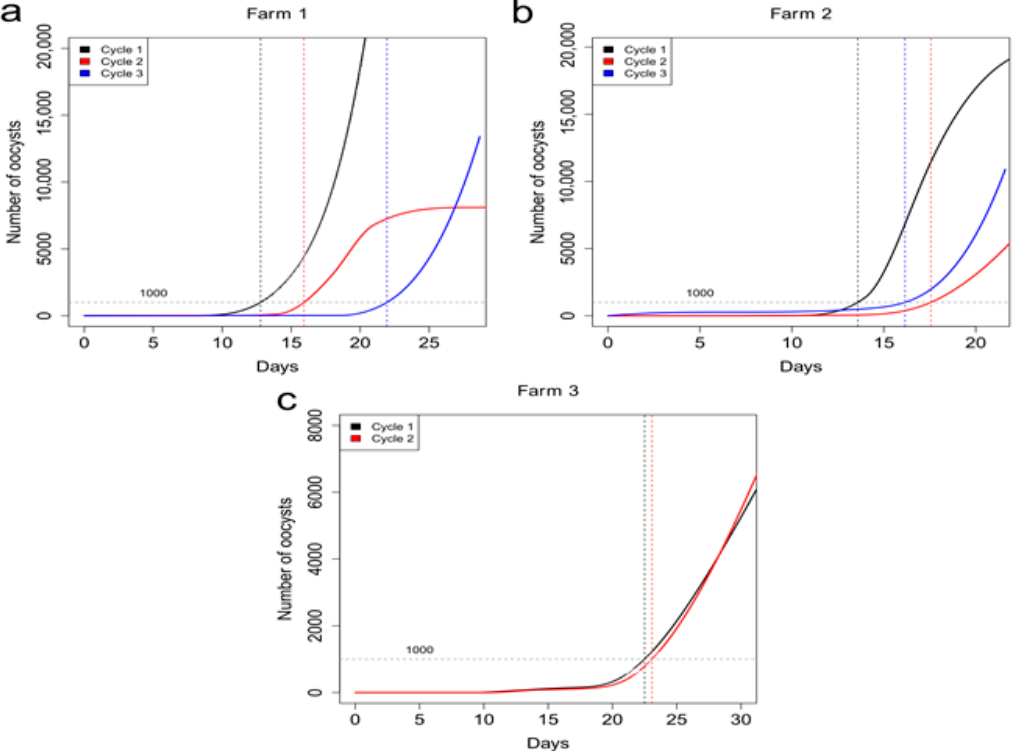
Figure 2. The number of oocystis interpolated from the oocyst count for each cycle and farm. The horizontal grey line refers to 1000 oocystis level. Farm 1 ( a ); Farm 2 ( b ); Farm 3 ( c ).